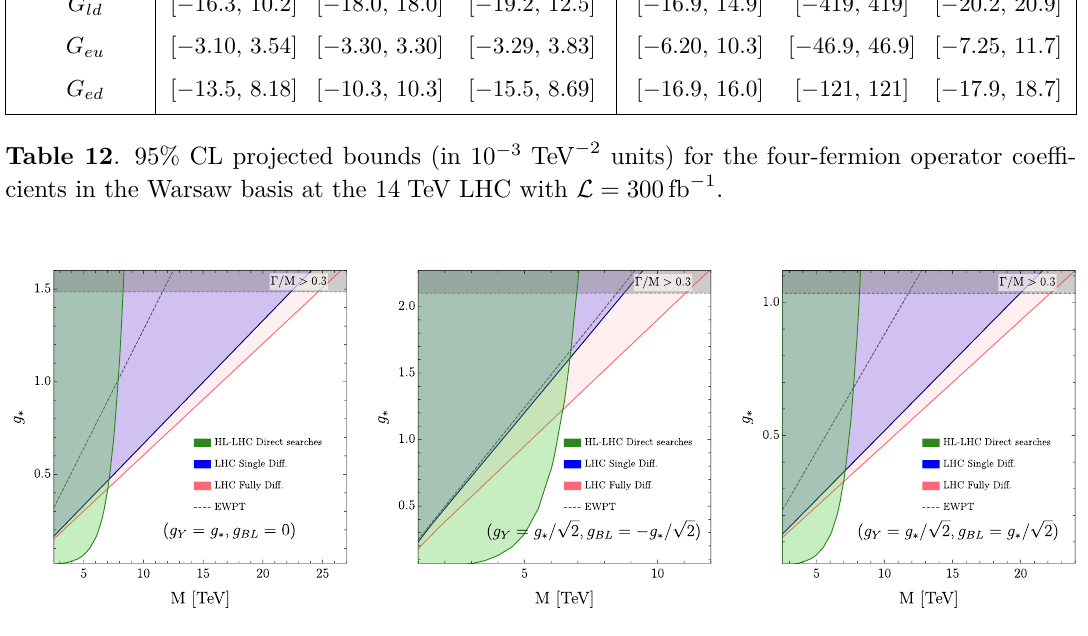
Figure 9 . 95% CL (1 d.o.f) exclusion reach in the mass/coupling plane for three different Z 0 benchmark models at LHC with L = 300 fb − 1 . The blue shaded region can be excluded through the fully-differential di-lepton DY analysis, while the orange one can be probed with the invariant- mass fit. The green shaded region corresponds to the exclusion from direct